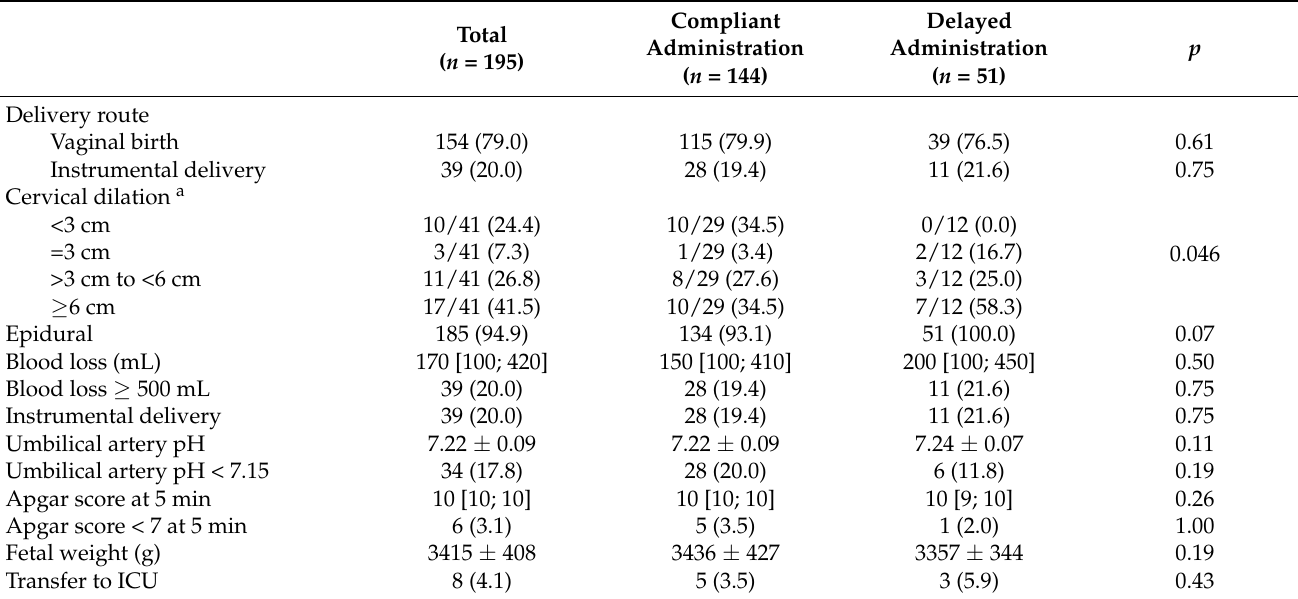
Table 6. Relation between compliance with protocol and delivery route, and postpartum and neonatal